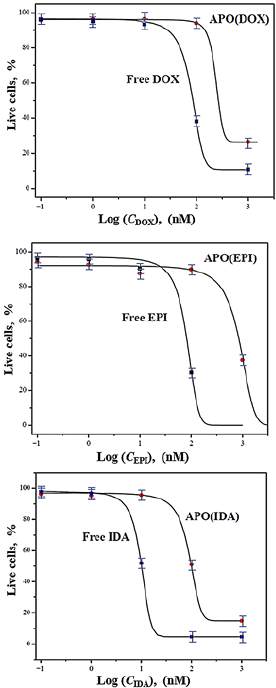
Figure 7. Dose–response curves for free ANTR drugs and APO-encapsulated ANTR nanodrugs, obtained for MDA-MB-231 breast cancer cells.